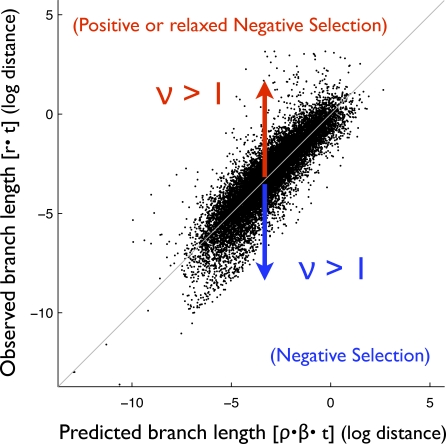
Evolutionary Rate Deviations as Evidence of Natural SelectionObserved branch length is plotted against the branch length predicted from gene-specific (ρ) and species-specific (β) effects (see Methods). A total of 16,681 points are plotted, corresponding to 744 orthologous proteins present in 16–30 species. Amino acid substitutions per site are shown on a log2 scale. The gray line corresponds to y = x.